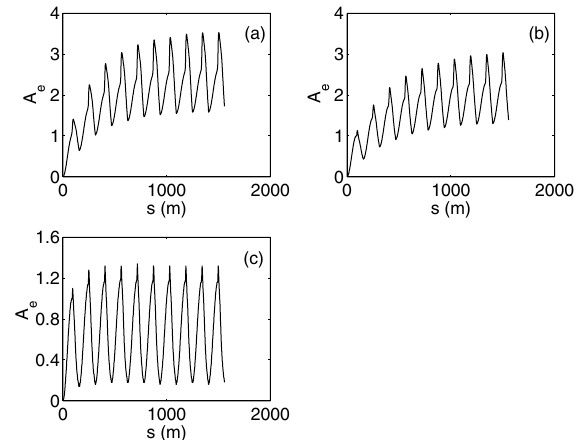
FIG. 4. Electron amplification factor. Electrons are produced at the beam position. (a) 3 GeV injection; (b) 3 GeVextraction; (c) 50 GeV injection.